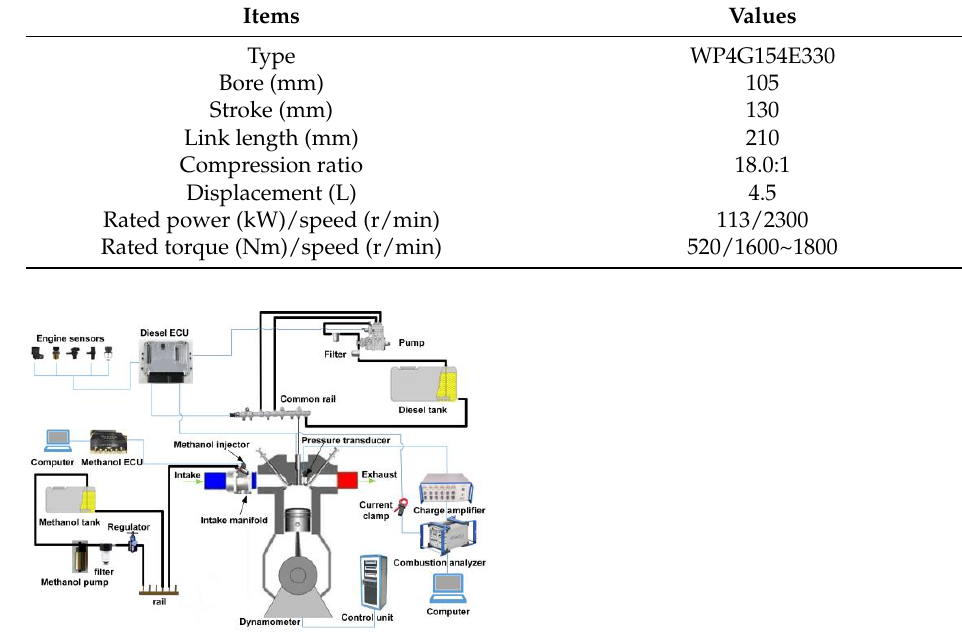
Figure 1. Schematic of engine test system.